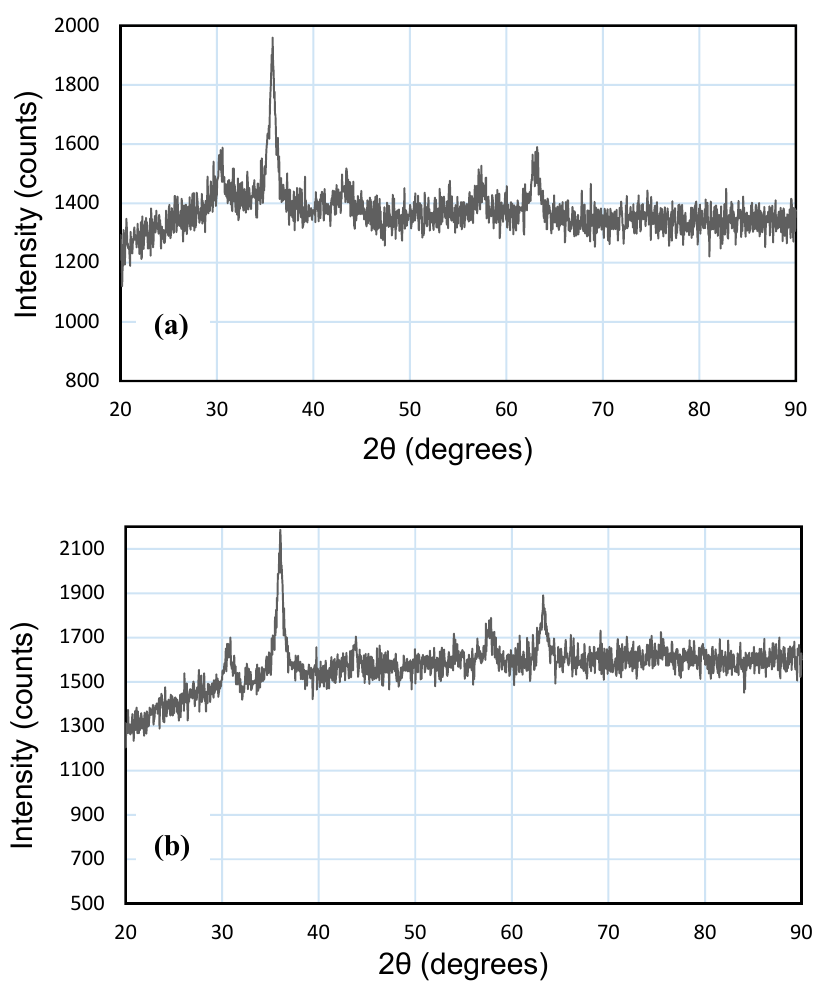
Figure 2. ( a ) X-ray di ff raction (XRD) analysis for maghemite nanoparticles (NPs). ( b ) XRD analysis for Figure 2. (a) X-ray diffraction (XRD) analysis for maghemite nanoparticles (NPs). (b) XRD analysis modified maghemite nanoparticles for modified maghemite nanoparticles (MNPs).